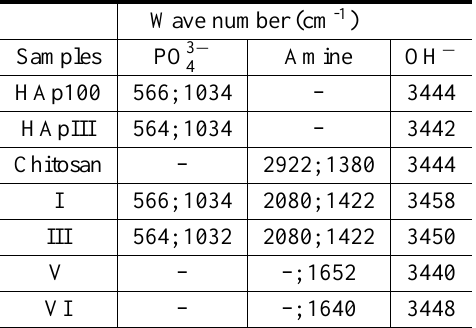
The shifts observed at the FTIR spectra of the characteristic bands from the functional